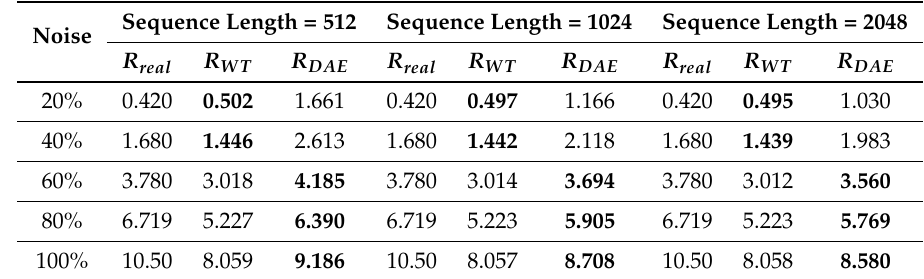
Table 6. Measurement noise variance accuracy on voltage data of different sequence lengths. The boldface numbers denote the best value in each experiment. Sequence Length = Noise